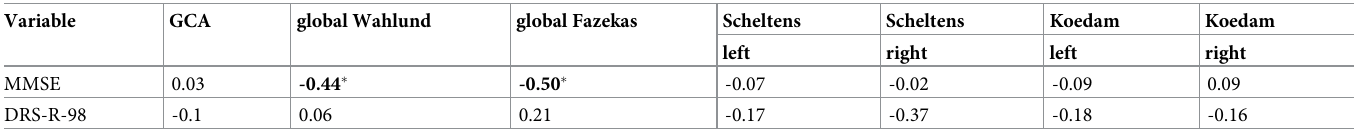
Table 2. Spearman rank order correlation for MMSE/DRS-R-98 total score (day 1) and the brain imaging biomarkers. Variable